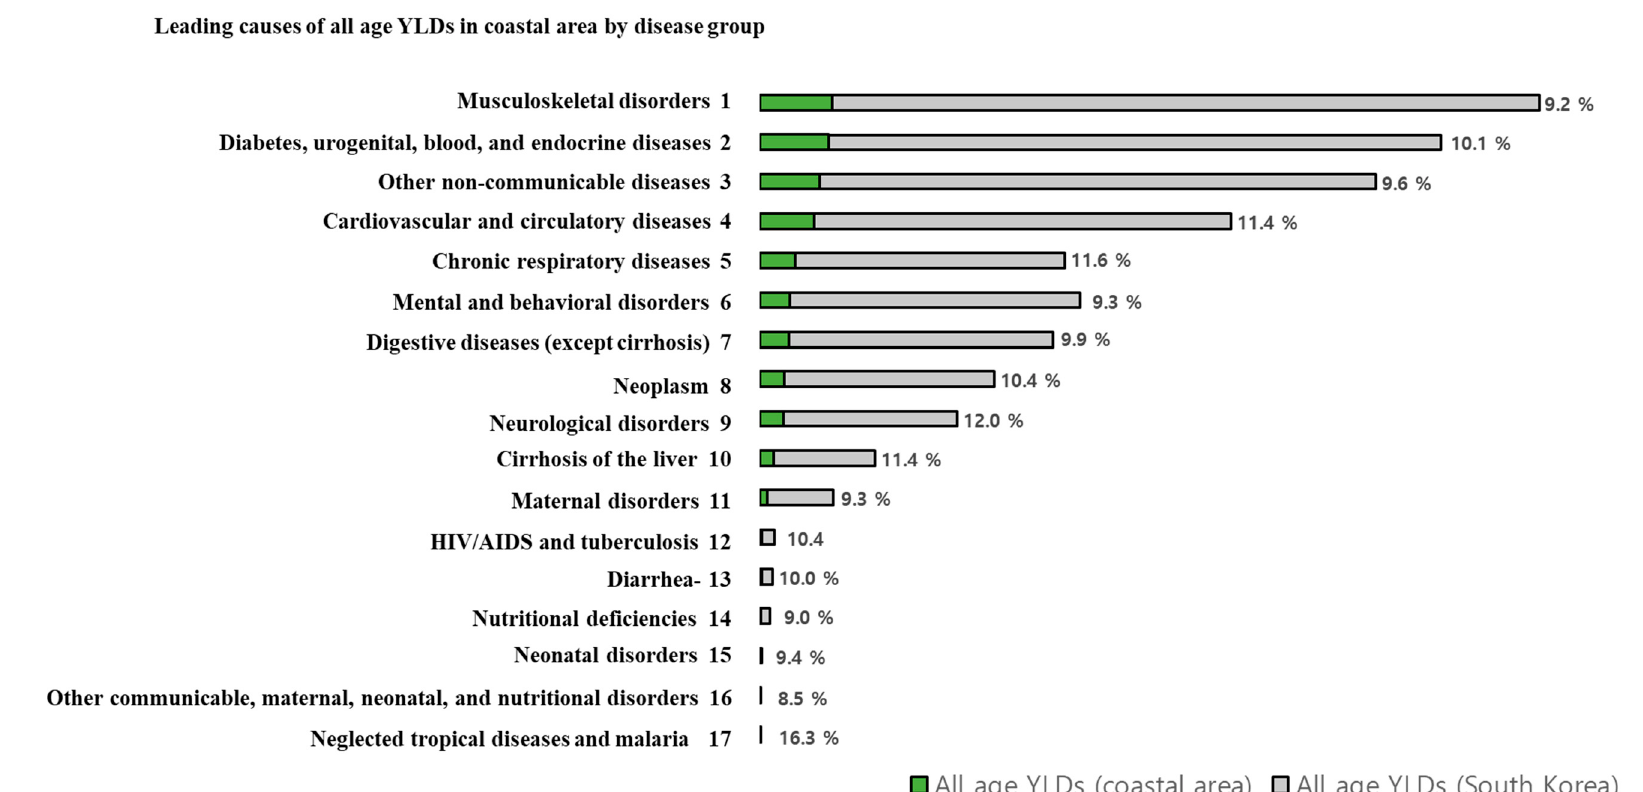
Figure 2. All age YLDs in coastal areas and in South Korea by Level 2 disease group, 2015. Abbreviations: YLDs, years lived with disability. Data refer to the proportion of all age YLDs in the coastal areas among South Korea’s all age YLDs. Sorted by descending all age YLDs in coastal areas.